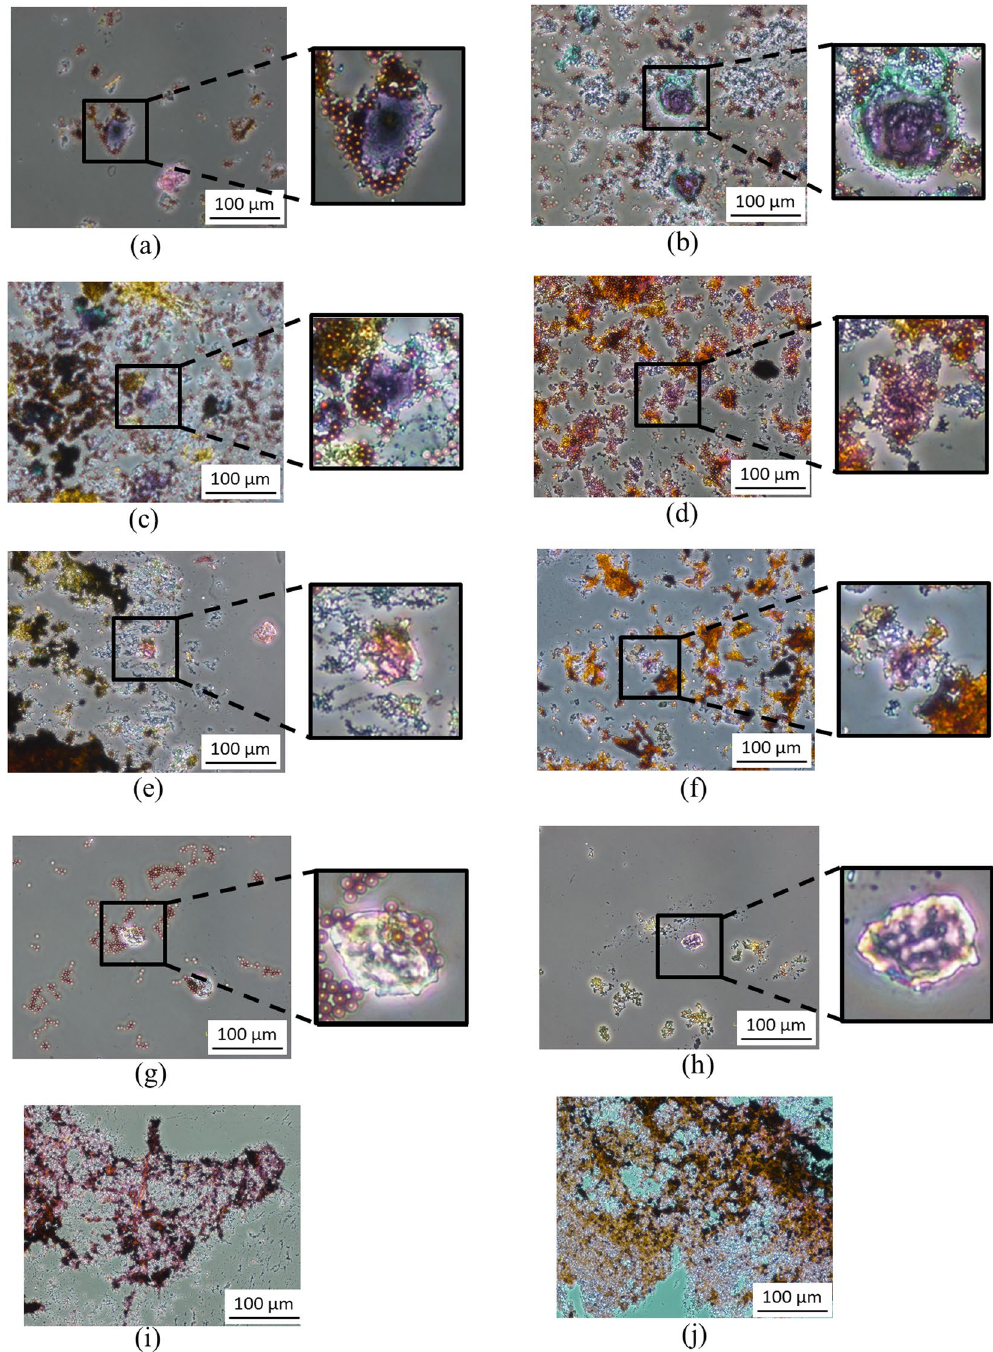
Figure 4. Bile specimens from eight cholangiocarcinoma (CCA) and two negative control patients analyzed by a bench-top bead-capture protocol followed by PAP staining. ( a ) Liver hilar tumor/CCA (stage IV). ( b ) CCA with lung metastases (stage IV). ( c ) Gallbladder cancer with lung metastases (stage IV). ( d ) Recurrent CCA (liver metastasis; stage IV). ( e ) Intrahepatic CCA (stage III). ( f ) CCA with peritoneal carcinomatosis (stage IV). ( g ) Malignant neoplasm of intrahepatic bile ducts (stage III). ( h ) CCA (stage IIIb, after chemotherapy). ( i–j ) Non-cancer patients